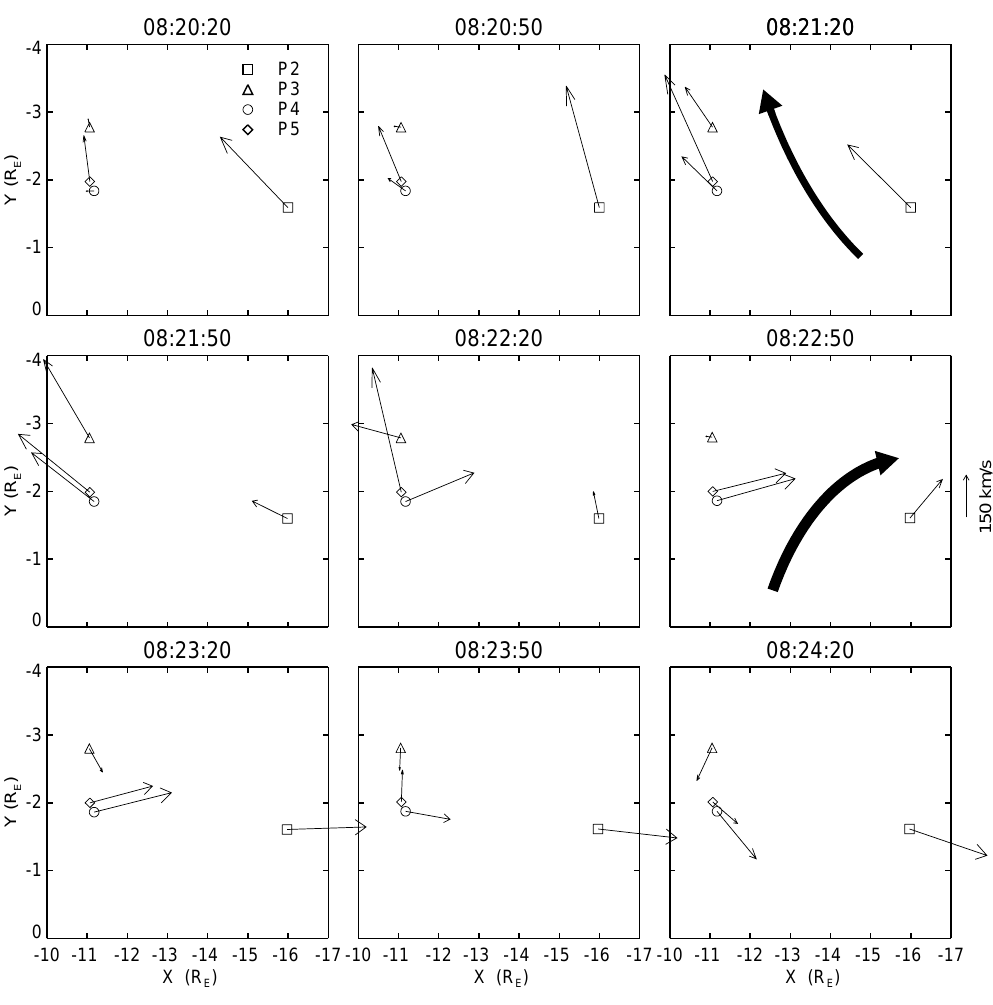
Fig. 5. THEMIS satellites (P2, P3, P4, and P5) positions overlaid with flow vectors.